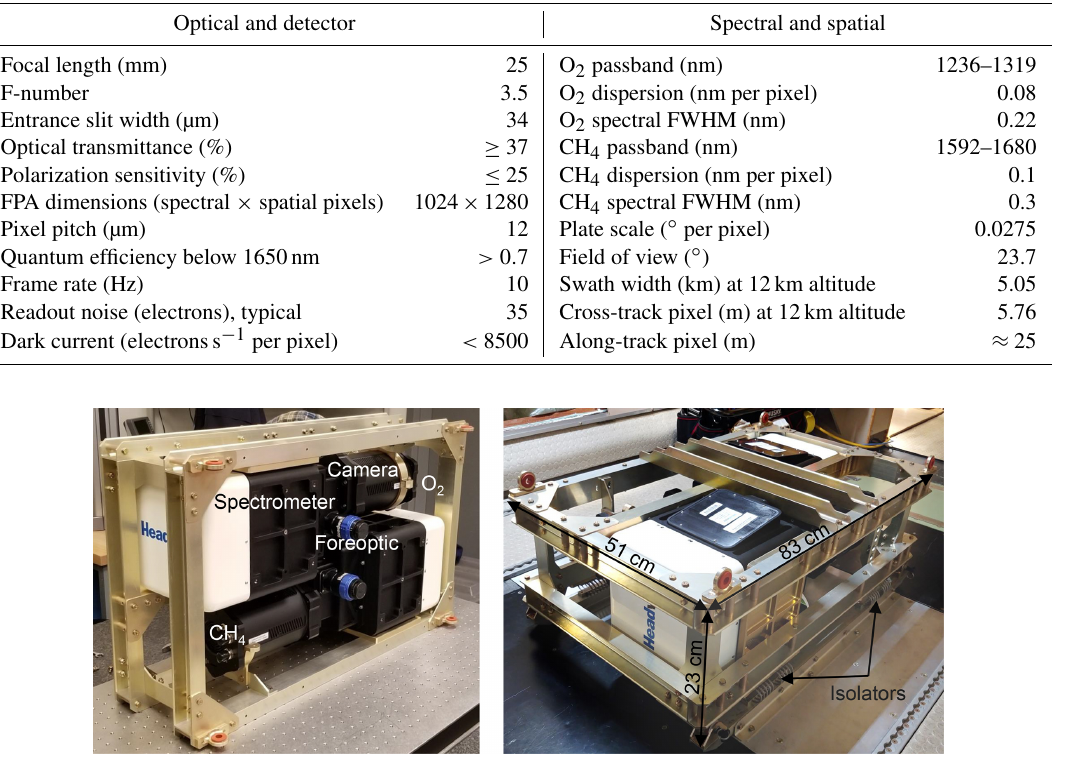
Figure 3. MethaneAIR instrument rack, side view (left) and down-looking configuration in the GV aircraft